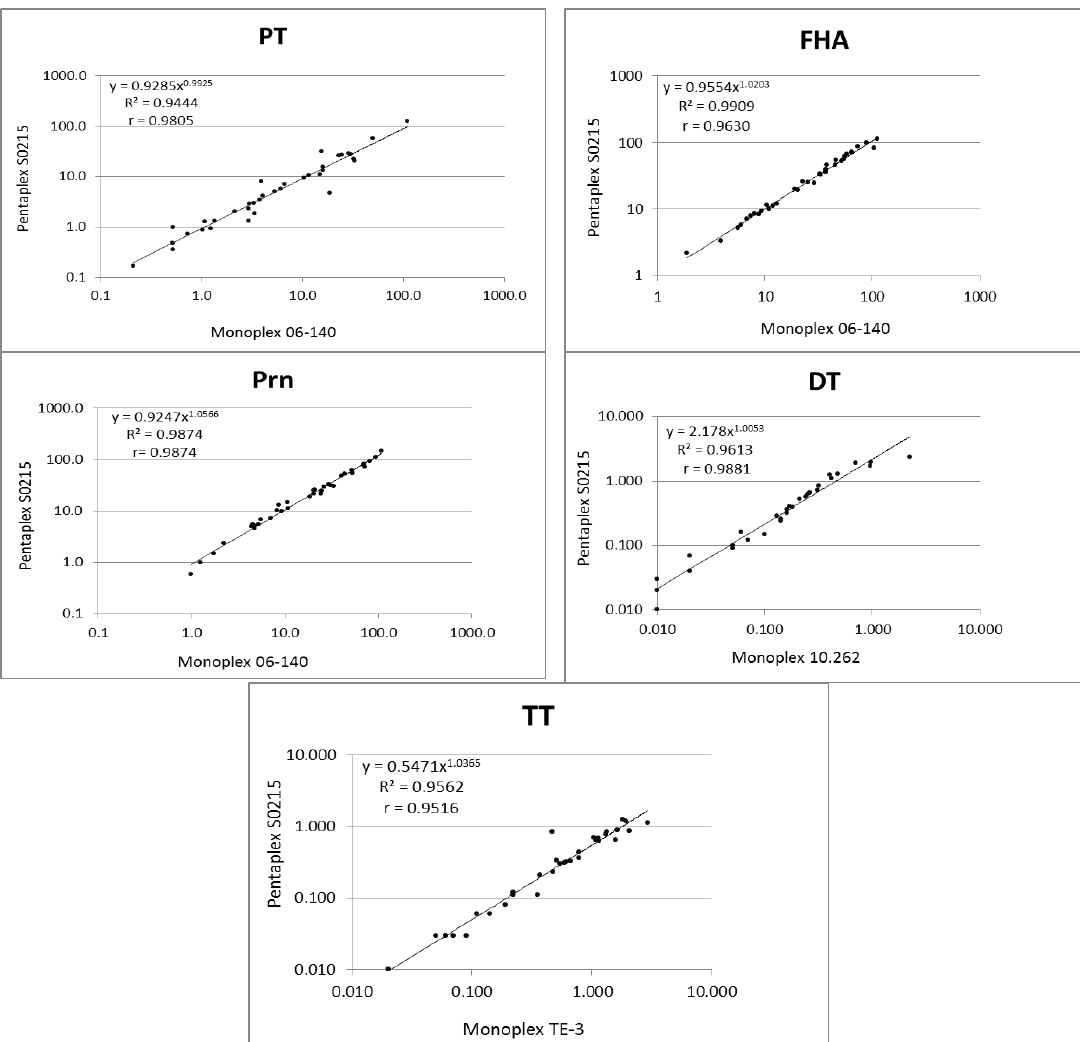
Figure 2. Correlation of anti-DT, anti-TT, anti-PT, anti-FHA and anti-Prn IgG antibodies detected in 37 serum samples using the pentaplex immunoassay (MIA) with the in-house standard and monoplex MIA using the international reference standards. Dots represent individual log-transformed antibody concentrations expressed in International Units per milliliter (IU/mL). R 2 represents the linear regression coefficient obtained using Microsoft Excel, and r represents the non-parametric Spearman correlation coefficient as calculated with GraphPad Prism Version 6 ( p < 0.0001 for all five analytes).